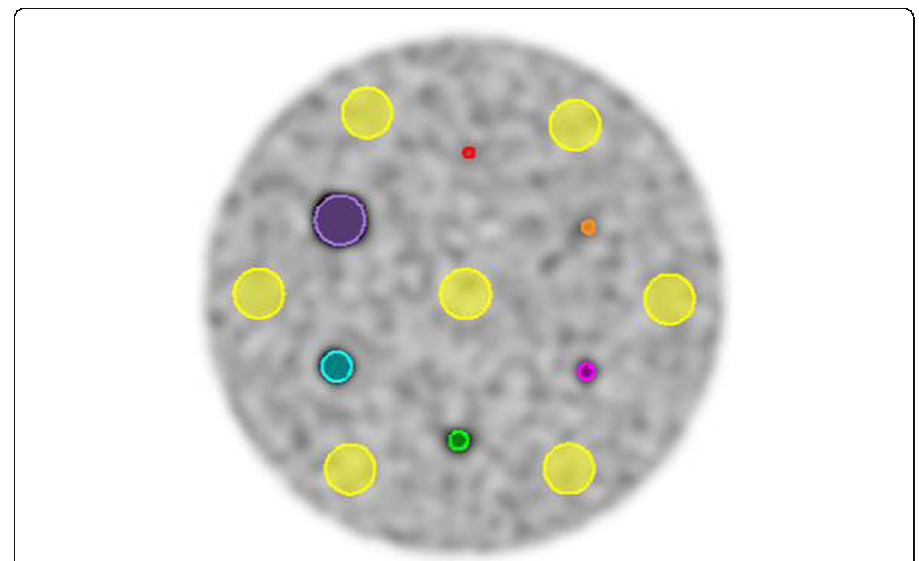
Fig. 2 Spherical VOIs placed over the hot spheres in OSEM with PSF and TOF with activity concentration of 8:1 (3 iterations, 2 mm voxel size) (purple: d = 20 mm, cyan: d = 12 mm, green: d = 8 mm, pink: d = 6 mm,